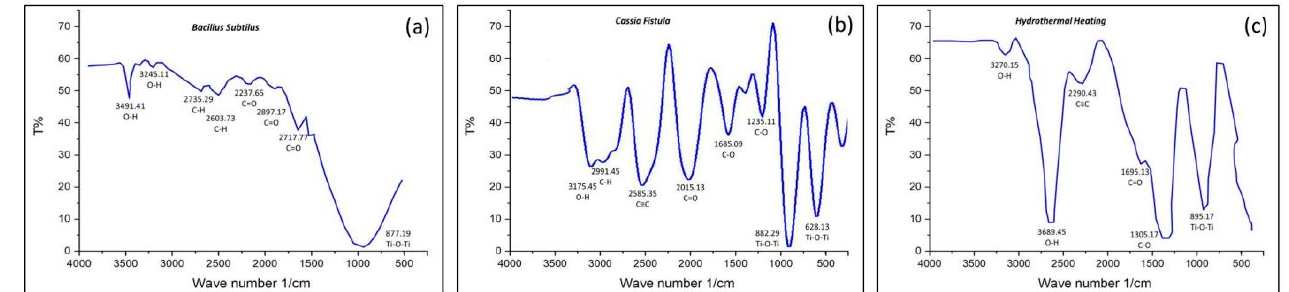
Figure 6. FTIR images of titanium nanoparticles formed by: ( a ) Bacillus subtilis , ( b ) Cassia fistula and ( c ) hydrothermal heating showing different functional groups and Ti–O–Ti vibrations.